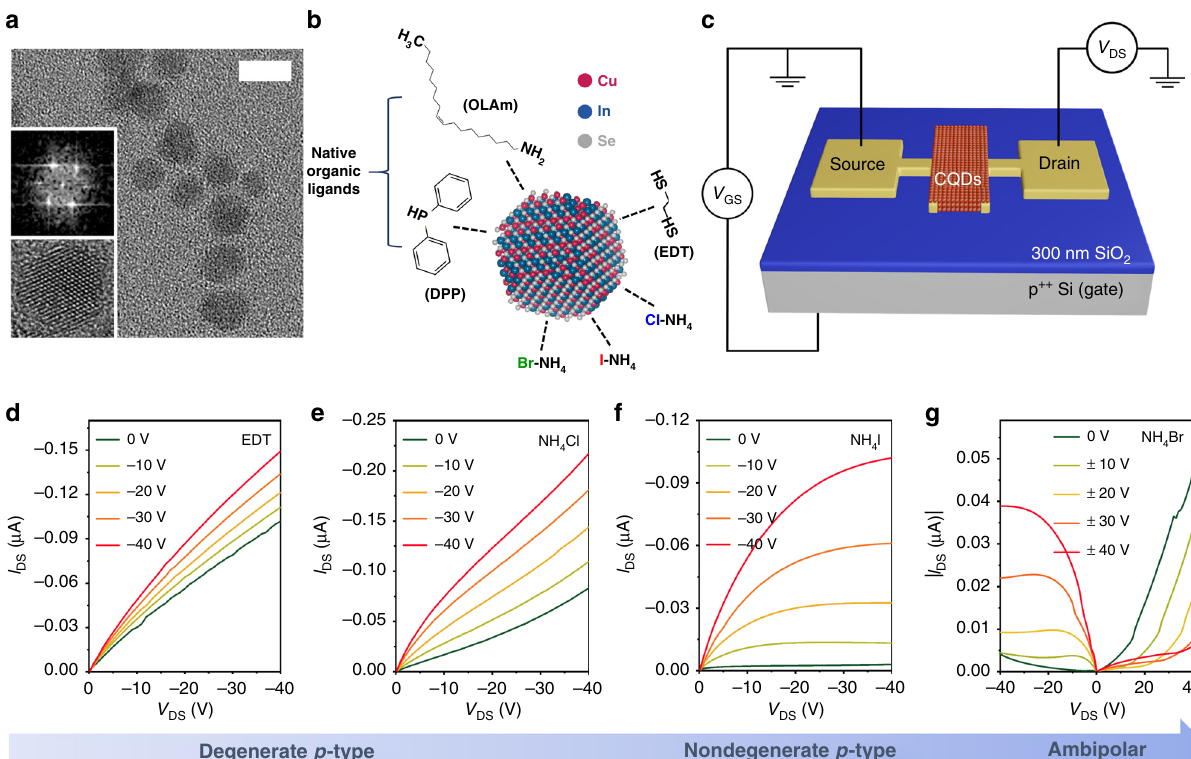
Fig. 1 CuInSe 2 CQD-based p -channel FETs. a A representative transmission electron microscopy (TEM) image (scale bar is 10 nm) of CuInSe 2 colloidal quantum dots (CQDs). The CQDs have a nearly spherical shape and are characterized by an average diameter of 7.3 ± 1.9 nm. A high-resolution (HR) TEM image of an individual CQD (lower inset) and a diffractogram of a “ boxed ” region obtained using a fast Fourier transform (upper inset) indicate the high crystallinity of the synthesized particles. b A schematic depiction of a CuInSe 2 CQD with the different types of surface ligands used in this study. As- synthesized CuInSe 2 CQDs are capped with molecules of oleylamine (OLAm) and diphenylphosphine (DPP). For carrier transport studies, the bulky native ligands are replaced with shorter species that include ethanedithiol (EDT), NH 4 Cl, NH 4 I, and NH 4 Br. c A schematic diagram of a bottom-gate, bottom- contact CQD- fi eld-effect transistor (FET). In p -channel FETs, source and drain electrodes are made of gold (100 nm thickness) deposited by thermal evaporation on top of a SiO 2 / p ++ Si substrate (the thickness of the SiO 2 layer is 300 nm). The channel dimensions are 3 mm (width) × 100 µ m (length). CuInSe 2 CQDs are deposited by spin-coating onto the prepatterned electrodes, and the original surface ligands are exchanged for EDT, NH 4 Cl, NH 4 I, or NH 4 Br. Output characteristics ( I DS vs. V DS ) of Au-contact FETs fabricated from CuInSe 2 CQDs with different types of surface ligands: EDT ( d ), NH 4 Cl ( e ), NH 4 I ( f ), and NH 4 Br ( g ). All devices were annealed at 180 °C for 1 h. The applied gate-source voltages ( V GS ) are indicated in the legends. Source data are provided as a Source Data fi